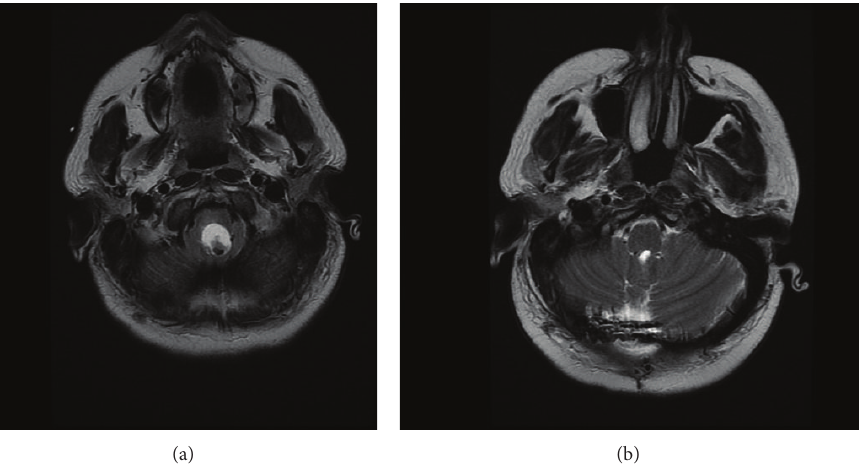
Figure 1: (a) Preoperative T 2 -weighted MRI with axial view depicting an ellipsoid hyperintense cystic mass, hydrocephalus, and brainstem compression. (b) Postoperative T 2 -weighted MRI with axial view depicting successful resection of